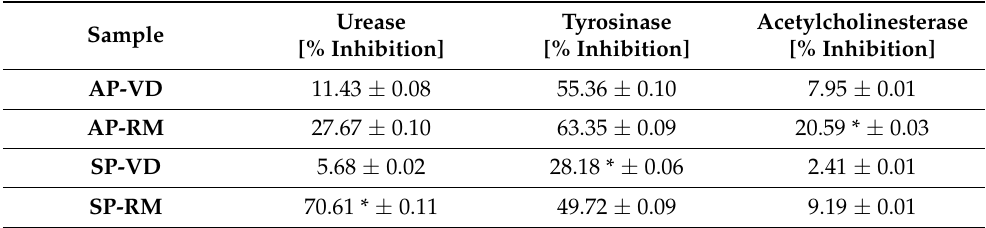
Table 4. The inhibitory capacity of aerial (AP) and subterranean parts (SP) of T. farfara hydro-ethanolic extracts on the enzymes urease, tyrosinase, and